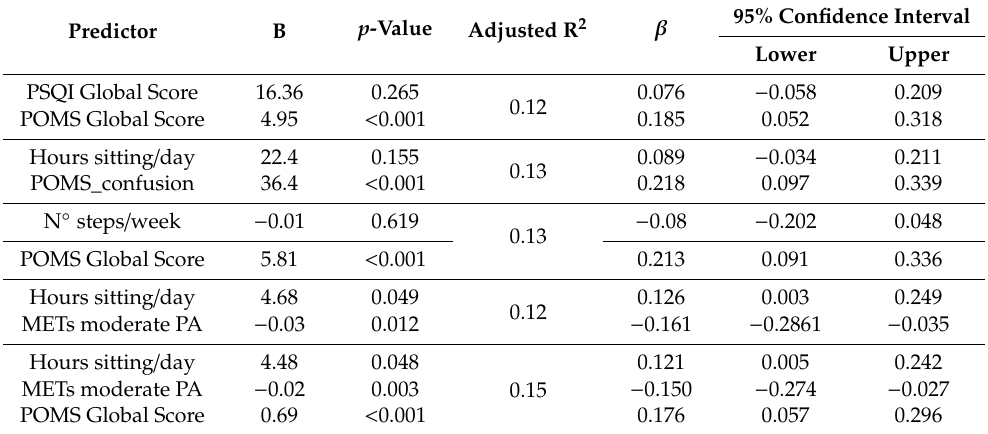
Table 2. Individual associations of physical activity, hours of sitting / day, POMS, PSQI, and hours of sitting / day with smartphone-use